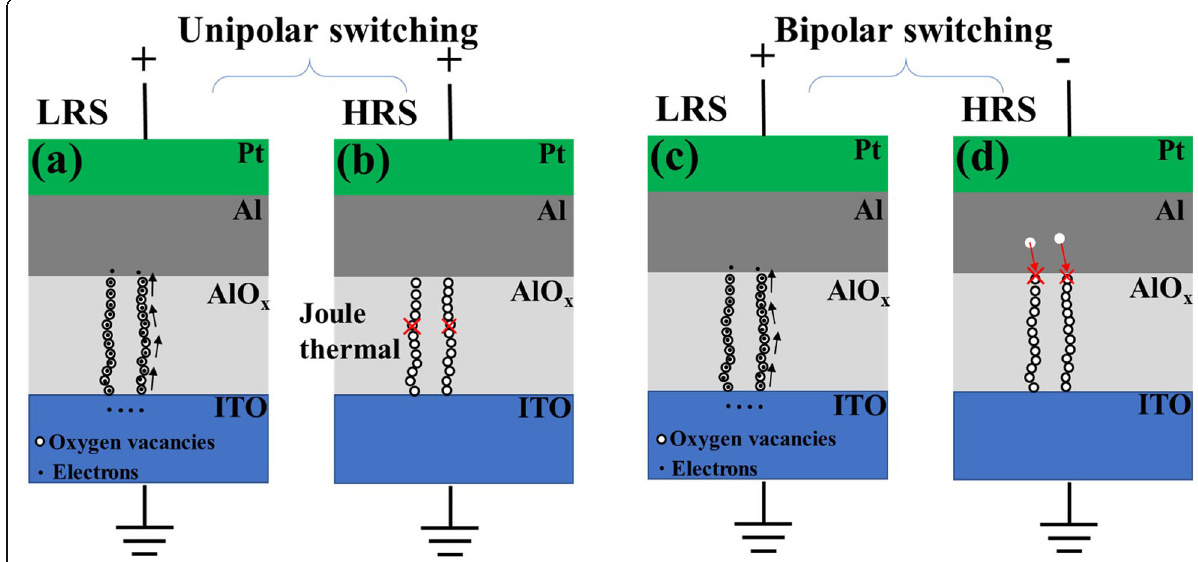
Fig. 7 The switching mechanism schematic of the AlO x -based RRAM device. ( a ) Set process for unipolar switching under a positive voltage. Conductive filaments consist of oxygen vacancies. The black arrows indicate the electron migration direction. ( b ) Reset process for unipolar switching under a positive voltage. The conductive filament is ruptured by Joule heating. Electrons are trapped by defects. The conductive mechanism in the HRS is dominated by SCLC. ( c ) Set process for bipolar switching under a positive voltage. ( d ) Reset process for bipolar switching under a negative voltage. The conductive filaments